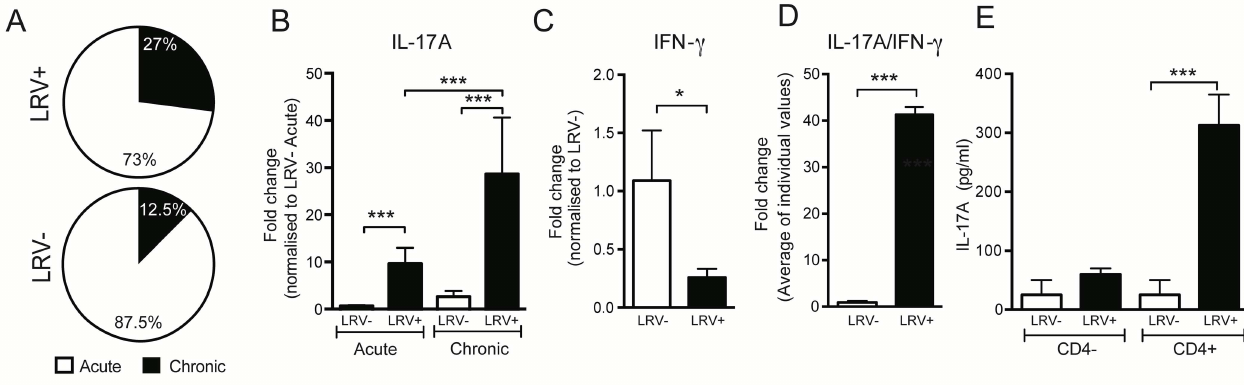
Fig 1. IL-17Aproduction is associated withLRV1 presenceand diseasechronicityin humancutaneous leishmaniasis. 78 cutaneous leishmaniasis patientsinfected with L . g parasiteswere separatedinto two groups based on theirLRV1 status (n = 30 LRV1+, n = 48 LRV1-). Two furtherclinical groups could be distinguished based on the durationof the patients’symptomaticinfection: 64 acute patients(lesionhistoryof 0–5 months)and 14 chronicpatients(lesionhistoryof 5–12 months). (A) Distribution of symptomatic cohortsamong LRV1+ and LRV1- infection. (B) IL-17Atranscriptswere measuredin all biopsiesby qRT-PCR. Values were calculatedusing the ΔΔ CT method and normalizedto the average of LRV1- L . g infection in the acute cohort. (C) IFN- γ transcriptswere measuredin biopsiesof acute patientsby qRT-PCR and normalized as before. (D) Previous qRT-PCR resultswere expressed for each individual as an IL-17A/IFN- γ ratio. (E) Lymphocytes were extracted fromblood samples of acute patients(LRV+ n = 5, LRV- n = 4) and separatedinto CD4+ and CD4- groups by MACS. Cells were re-stimulated ex vivo with L . g parasites priorto IL-17Aquantification by ELISA in supernatants. Data are mean +/- SEM using at least 2 technicalreplicatesper condition. Significance tested by an unpaired,parametric t -testand indicatedas * : P < 0.05, ** P < 0.005, *** P <